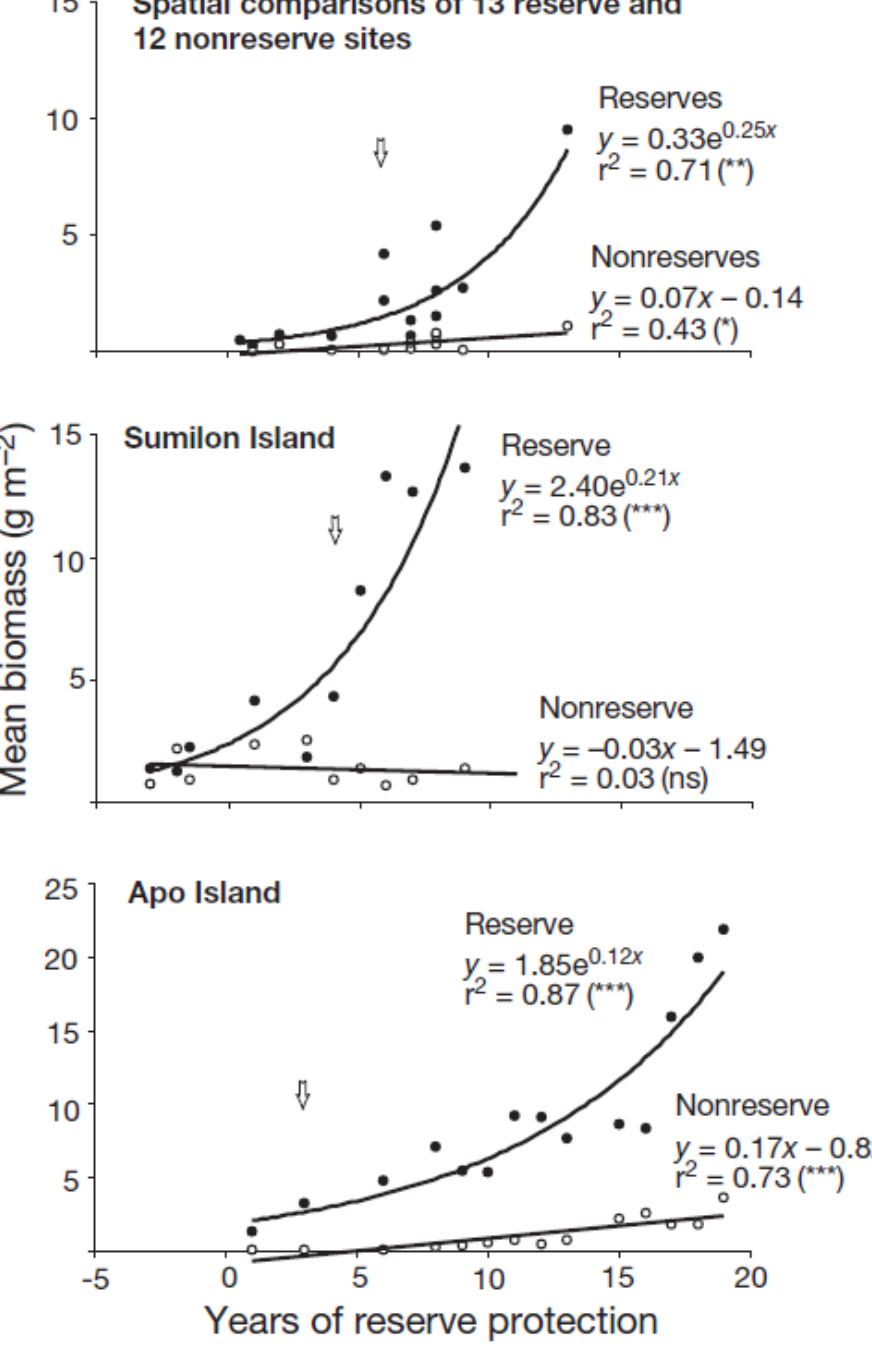
Figure 5. Strong evidence of increases in biomass of “large” predatory reef fish (snappers, medium groupers, etc. ) biomass inside reserves greater than in non-reserve control areas in the Philippines. The top graph shows several sites established for different durations with data taken at the same time, and the bottom graphs show two sites over time. Reproduced from [262] with